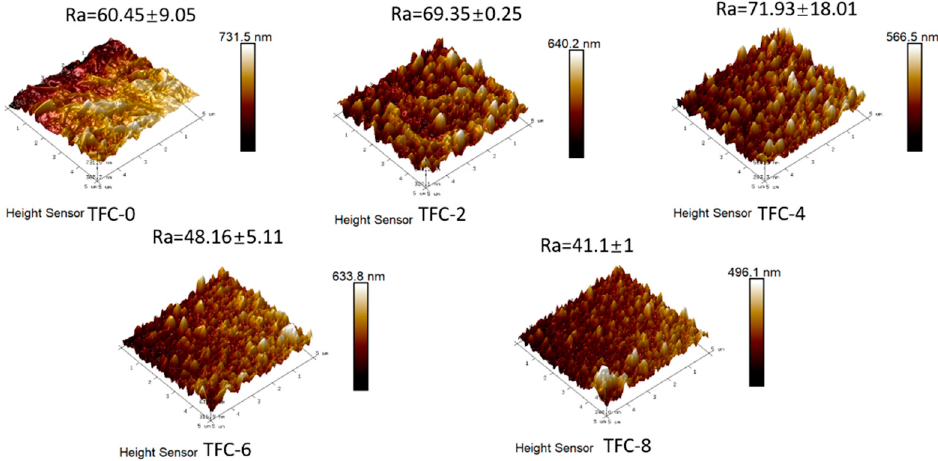
Figure 4. AFM surface roughness and surface area ratio of the TFC polyamide FO membranes.